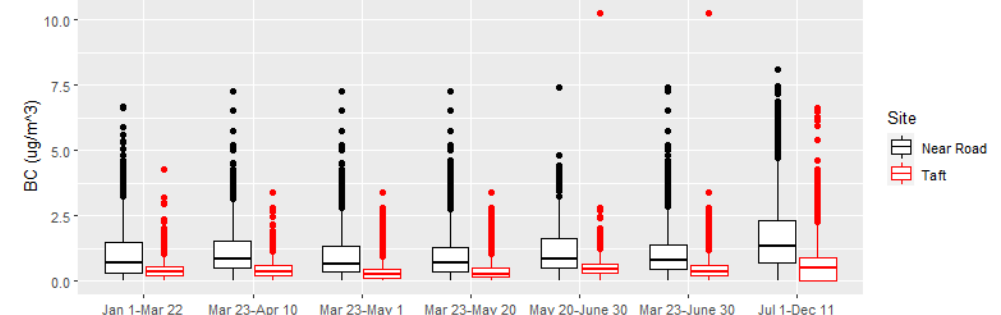
Figure 9. Boxplots of hourly BC during each time period of interest during 2020 at the Near Road and Taft sites.